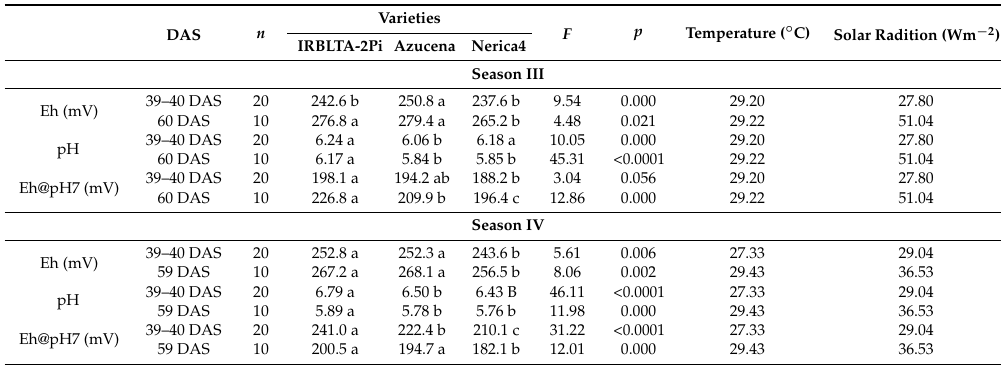
Table 4. Means and pairwise comparisons of Eh, pH and Eh@pH7 of three rice varieties (Nerica4, IRBLTA2Pi, Azucena) at two plant ages (39–40 and 60 DAS, (days after sowing)) in two growing seasons/fertilization, in aerobic conditions. In season III plants were sown 12 August 2016 and fertilized with NPK. In season IV plants were sown 2 December 2016 and fertilized with Hoagland solution. Measurements were made on the middle part of the last fully expanded leaf of the main tiller. Mean temperature and solar radiation at the day of measurement are indicated. Data for the plant ages 39 and 40 were pooled, details and pairwise comparisons are given in Table S4. F and p values of the ANOVA are indicated. Values followed by different letters indicate significant difference between varieties at 95% confidence interval (REGW- Q test).